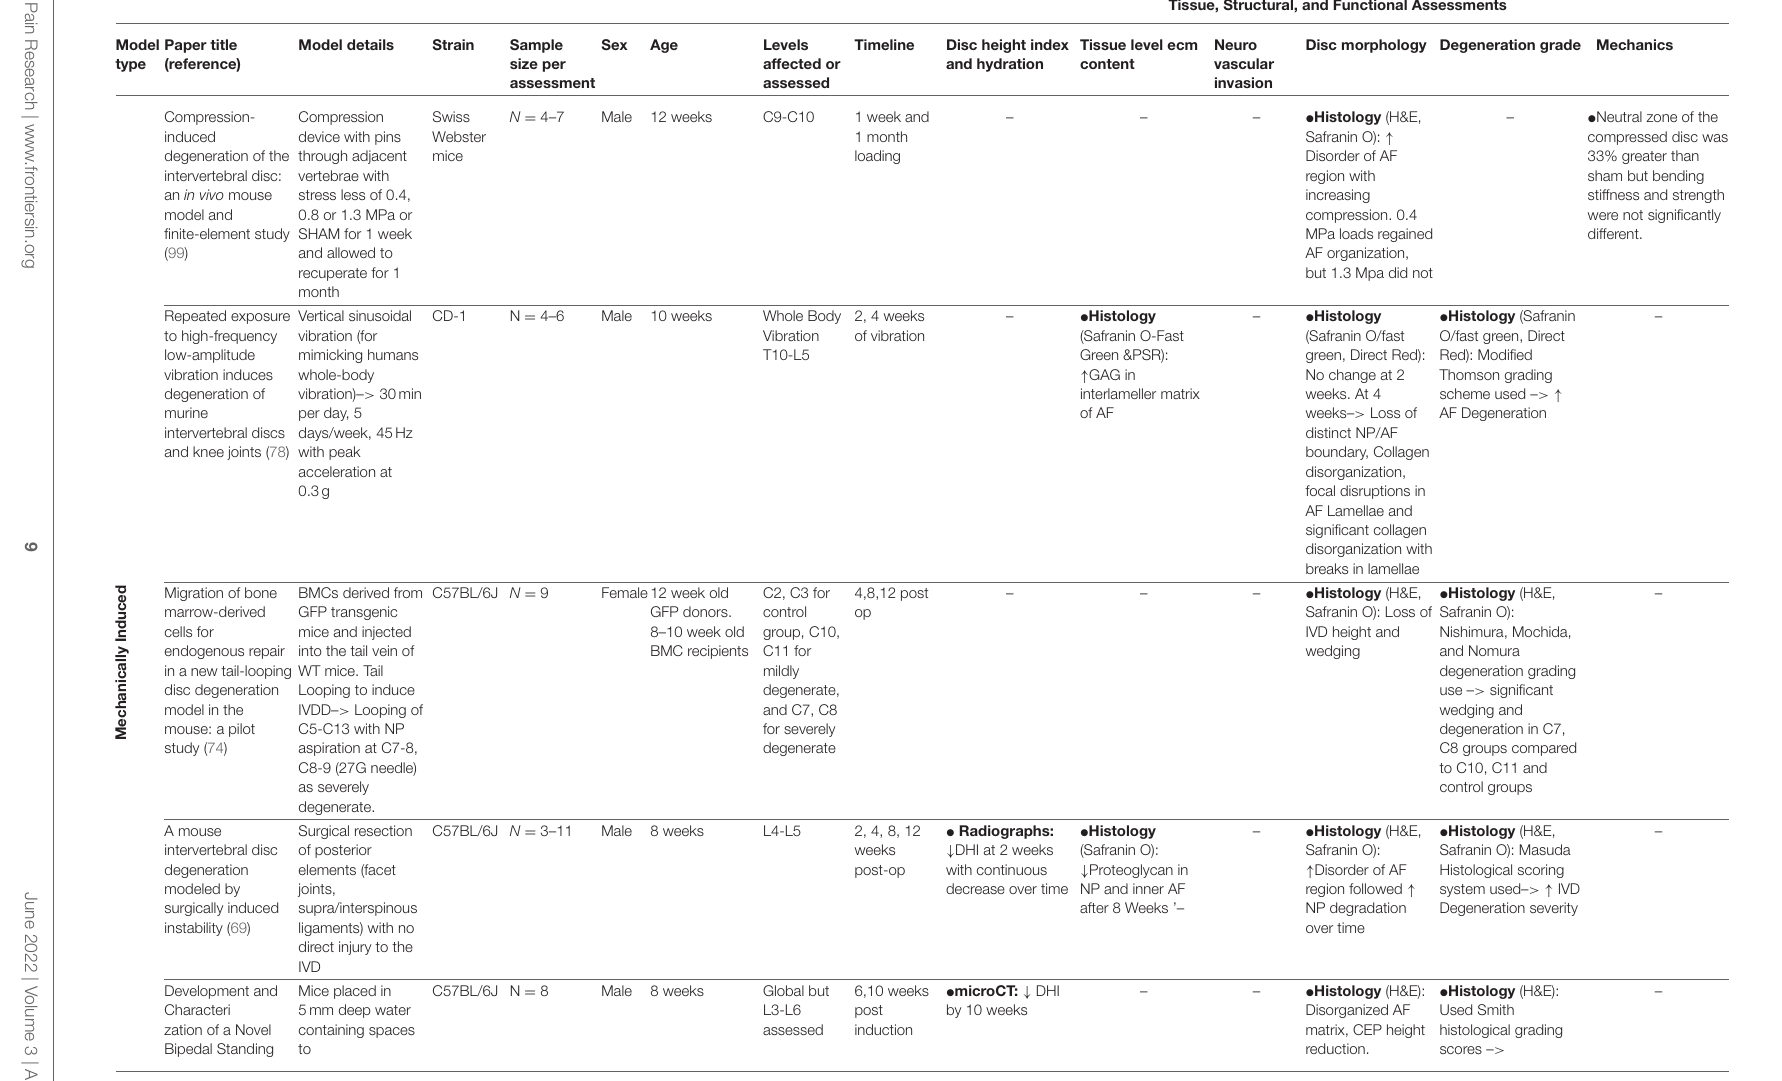
Tissue, Structural, and Functional